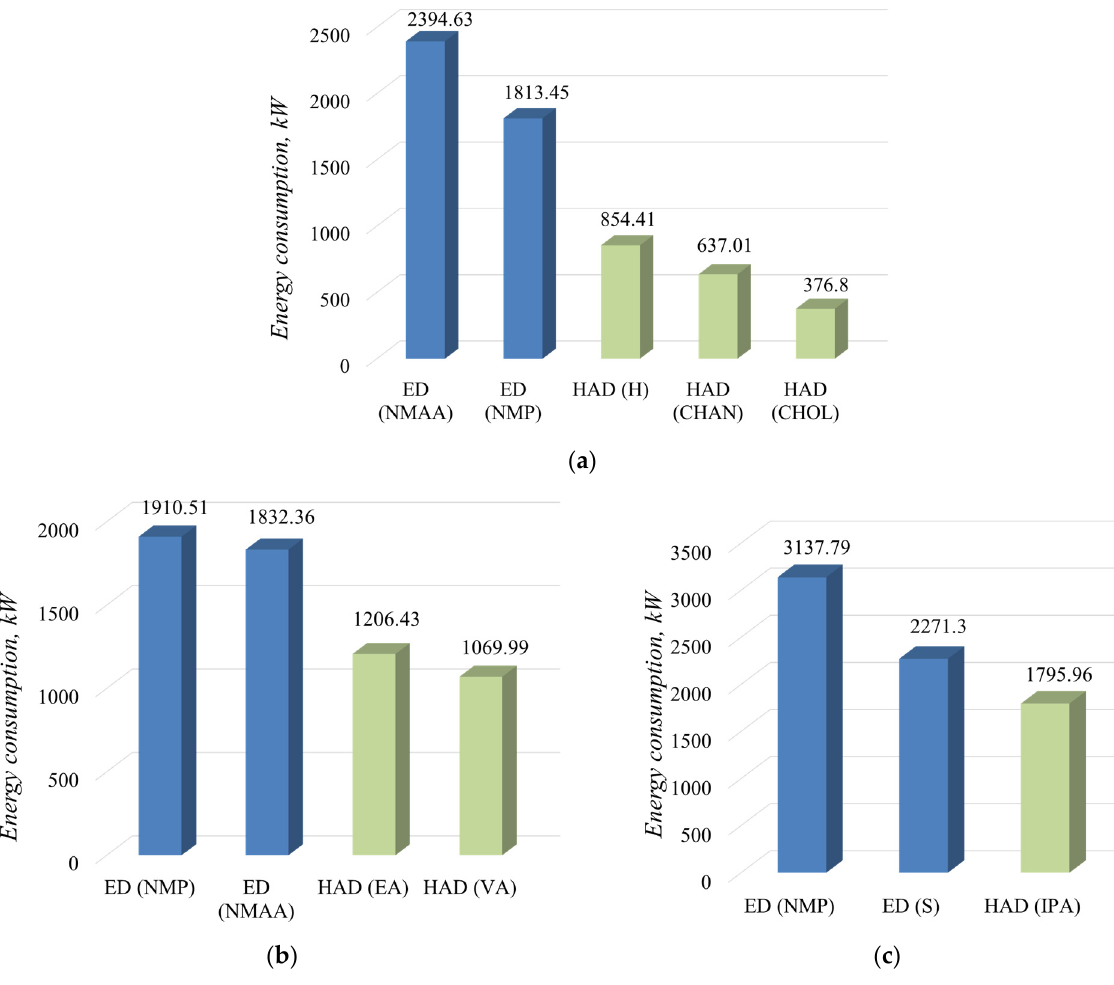
Figure 3. Comparison of flowsheets’ energy consumption for separation of PA + W ( a ), AA + W ( b ), and MP + W ( c ) binary mixtures. and MP + W ( c ) binary